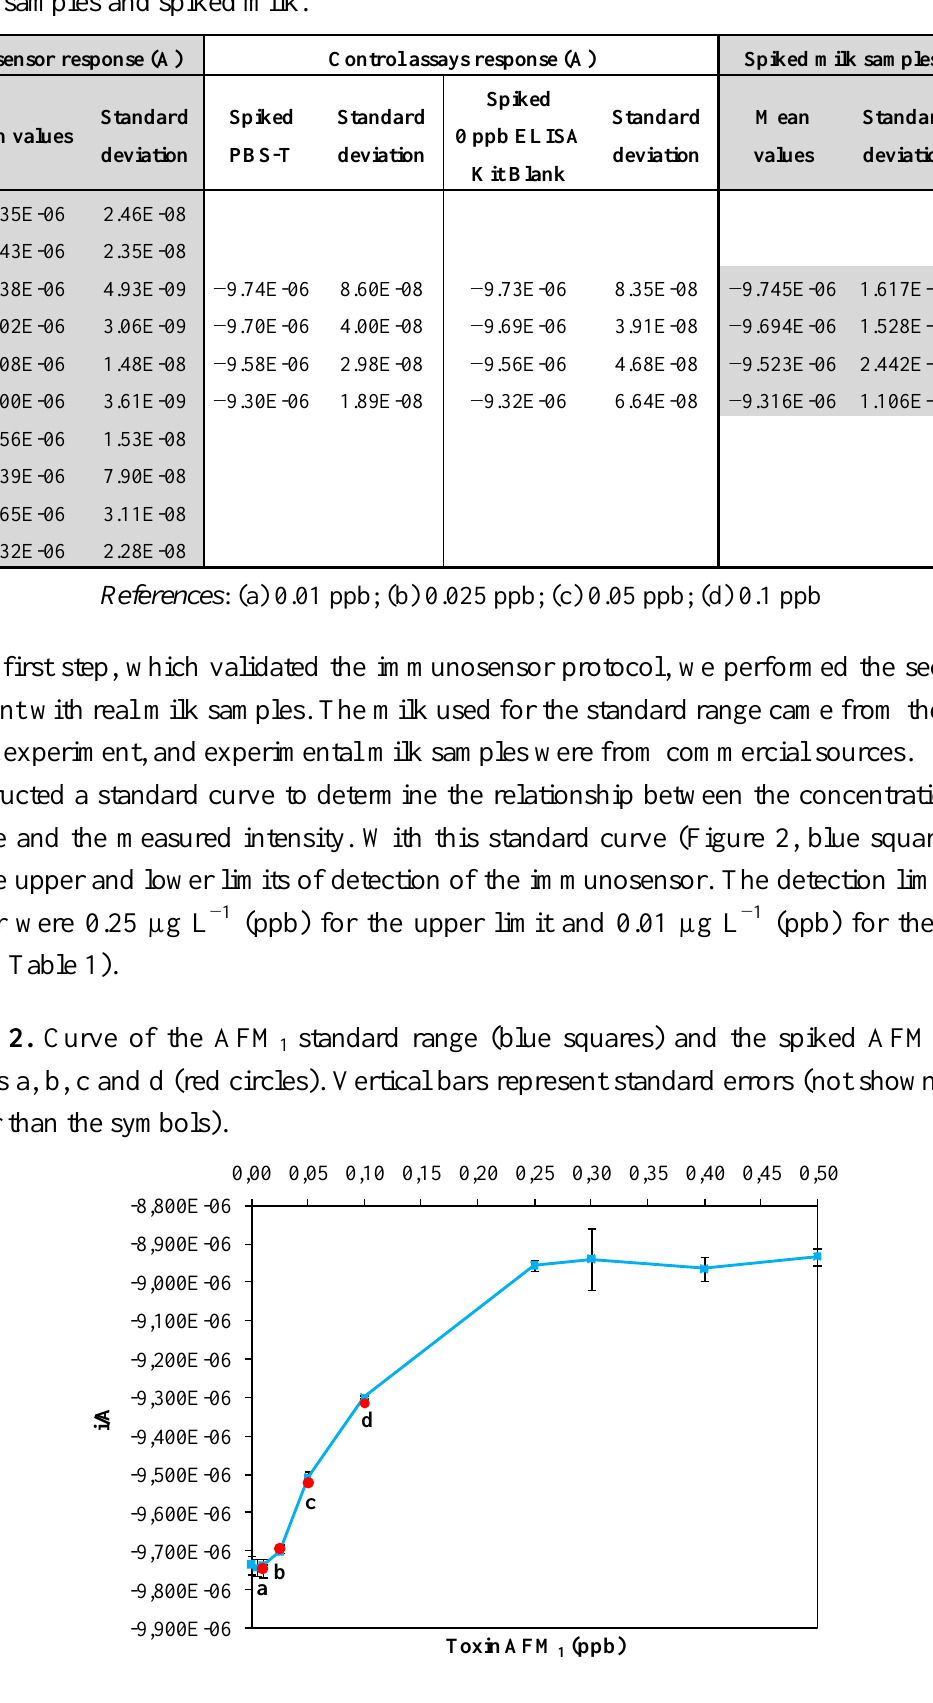
and results obtained using 1